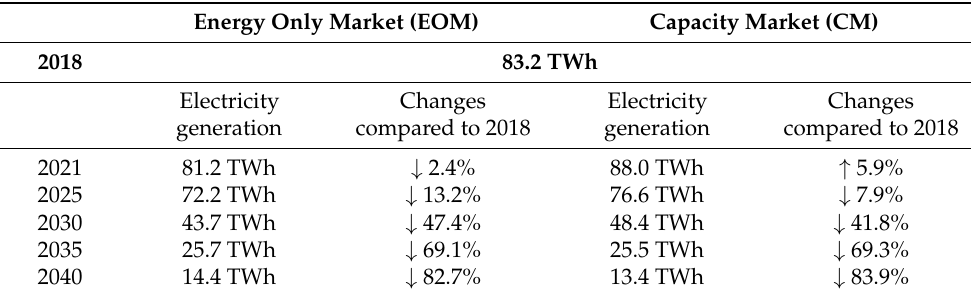
Table 6. Electricity generation in hard coal-fired power